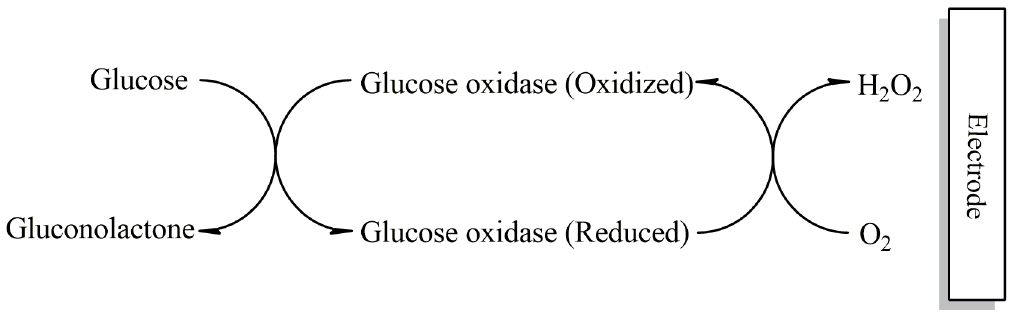
glucose biosensors: Ultimate EZ Smart Plus test strips (EZ Smart) and Contour blood glucose test strips (Bayer Healthcare